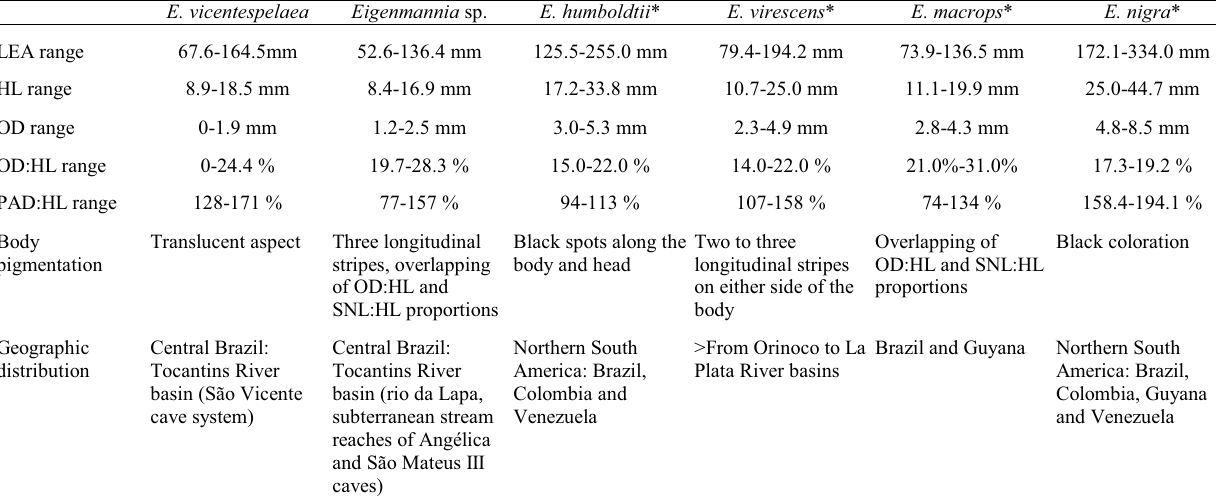
Table 2 . Compared data of Eigenmannia species from South and Central America. * Data from Mago-Leccia (1978, 1994) and Albert (2001,